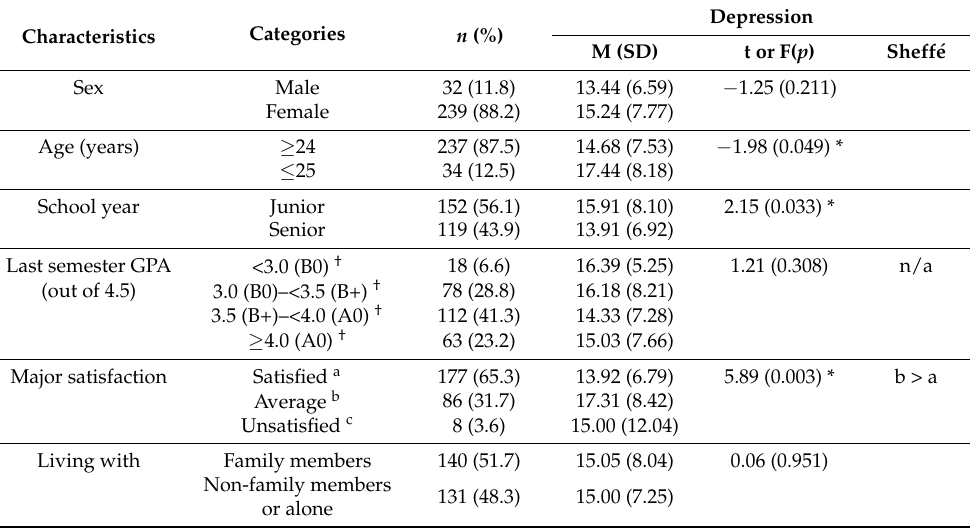
Table 1. General Characteristics of Participants and Differences in Depression According to General Characteristics ( n =